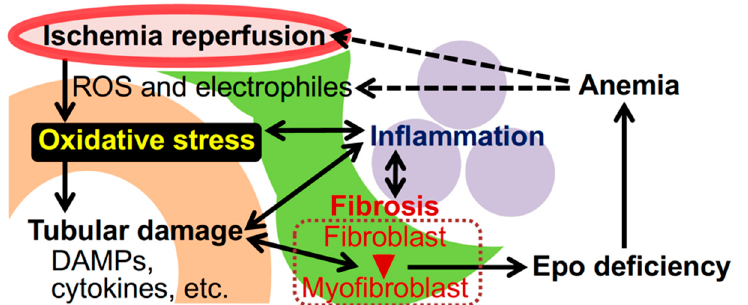
Figure 1. Oxidative stress and kidney disease. Irregular blood flow in the renal capillaries (red) provokes ischemia-reperfusion injury (IRI), followed by the emergence of ROS and electrophiles, which are causes of oxidative stress. Accumulated oxidative stress injures epithelial cells of renal tubules (orange), and damaged cells scatter damage-associated molecular patterns (DAMPs) and inflammatory cytokines. Tubular damage induces inflammation mediated by myeloid cells (purple) as well as transformation of interstitial fibroblasts (green) into myofibroblasts that promote kidney fibrosis. The myofibroblastic transformation impairs Epo production by renal interstitial fibroblasts (also known as REP [renal Epo-producing] cells) and causes renal anemia. Anemia and inflammation further enhance oxidative stress in kidneys.